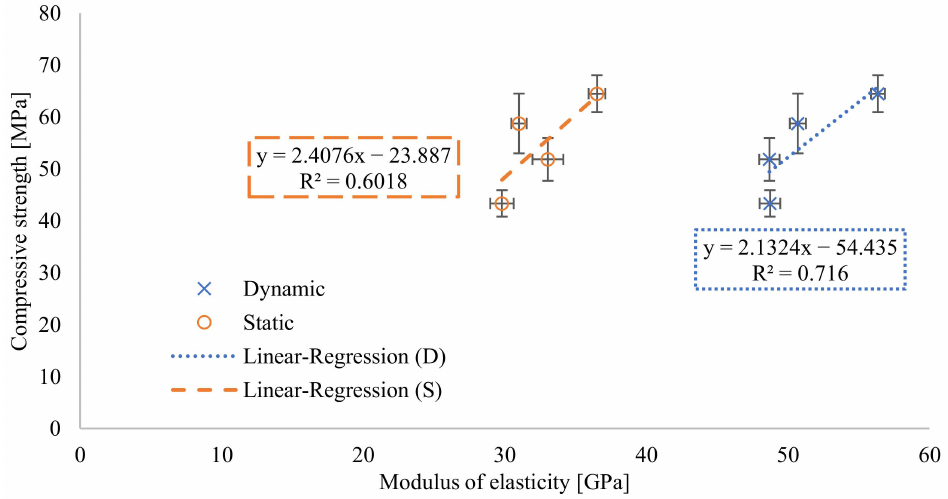
Figure 7. Linear regression analysis of the relationship between modulus of elasticity and compressive strength (D = Dynamic, S =